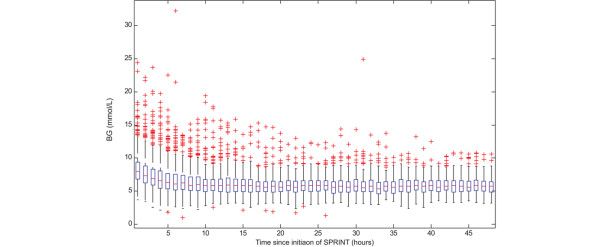
Hourly blood glucose average values for all patients on Specialised Relative Insulin Nutrition Tables (SPRINT). Boxes represent the interquartile range (IQR) containing the median, whiskers represent 1.5 times the IQR, and crosses represent outlying measurements beyond this range. BG, blood glucose concentration.